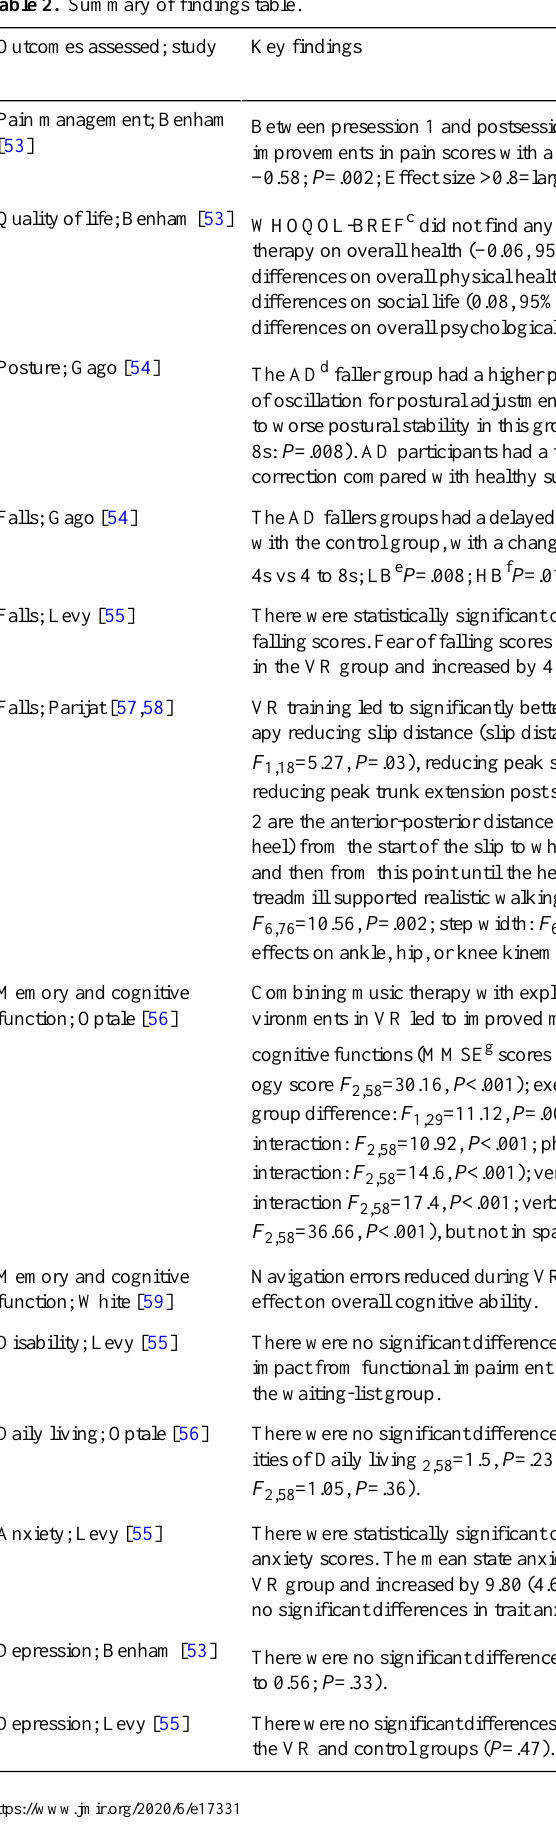
Table 2. Summary of findings table.